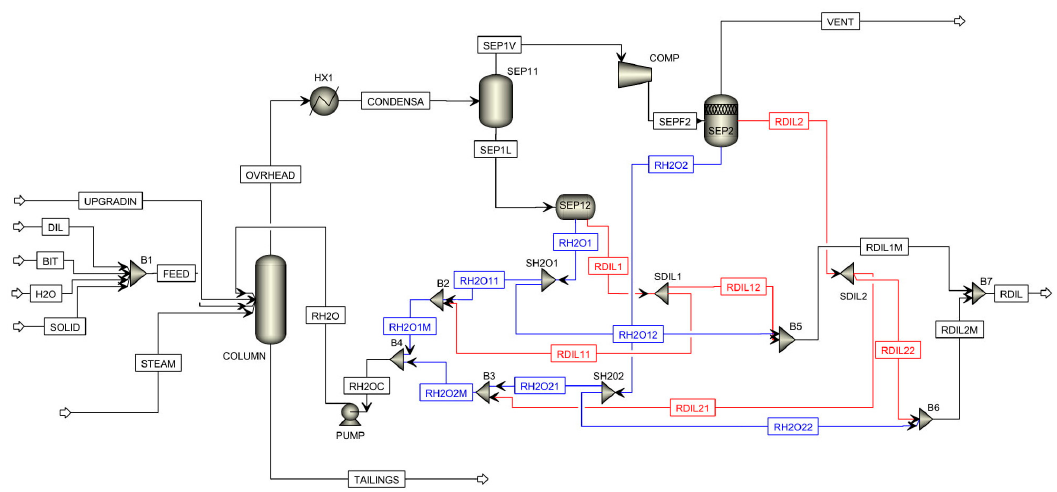
Figure 14. Configuration of the “withdraw and remix” design for the overhead system.